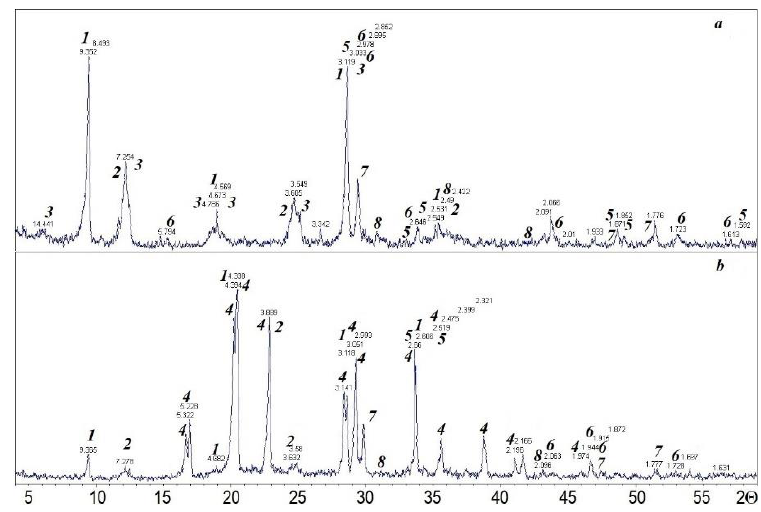
Figure 1. XRD pattern of the original concentrate ( a ) and of the concentrate mixture with ammonium sulfate ( b ). Numbers indicate reflexes: 1—talc; 2—lizardite; 3—clinochlore; 4—mascagnite; 5—chalcopyrite; 6—pyrrhotite; 7—pentlandite; 8—magnetite.